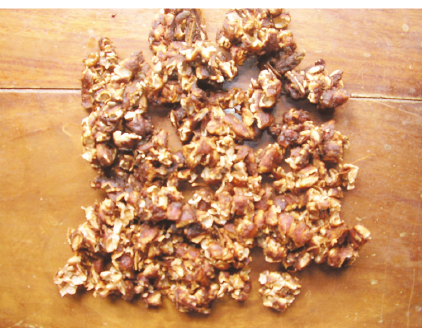
Figure 2: Morphological triplicate measurements.